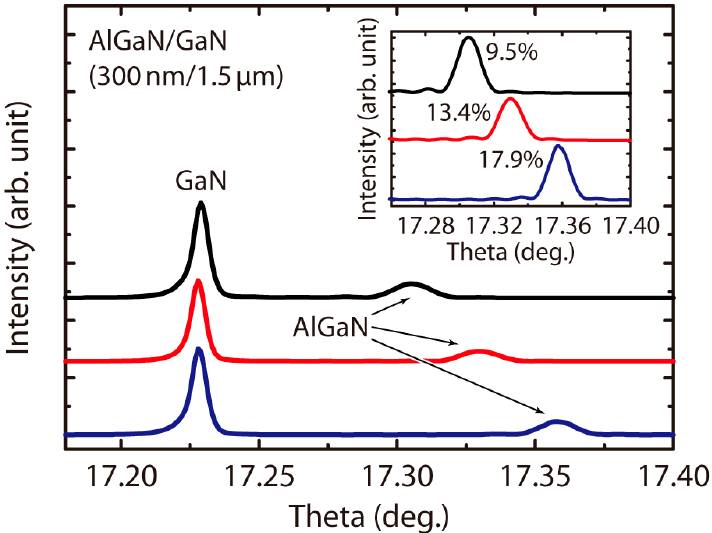
Figure 2. High-resolution XRD measurements of the (0002) planes of AlGaN samples with various Al mole fractions (inset: enlarged view of the AlGaN peaks).